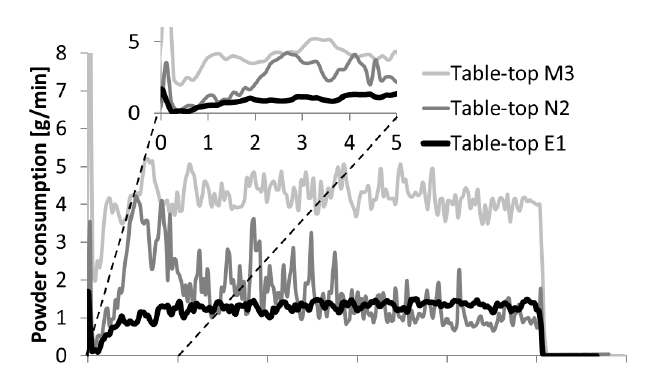
Table 2. Powder consumption and autonomy: the statistical differences are compared between Table-Top E1 for Table-tops and Handy E1 for Handies.